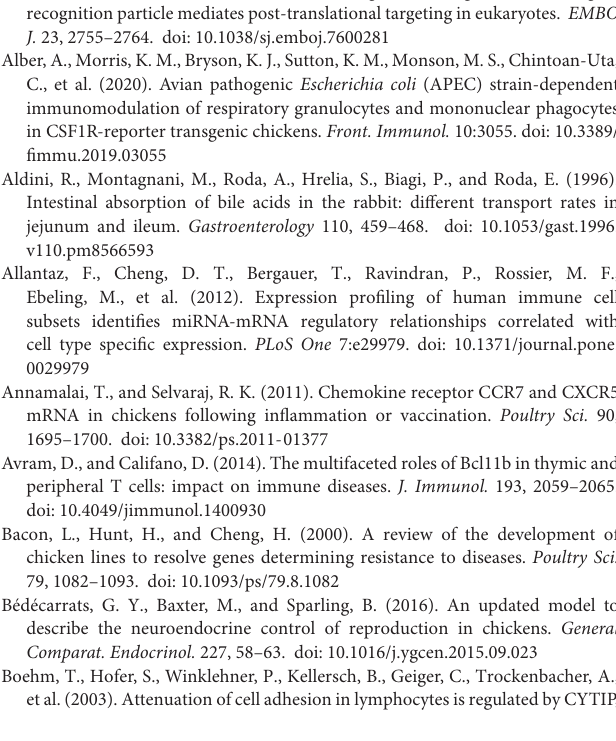
bursa DESeq2 results. (Sheet 3) Bursa vs. thymus DESeq2 results. (Sheet 4) B cell